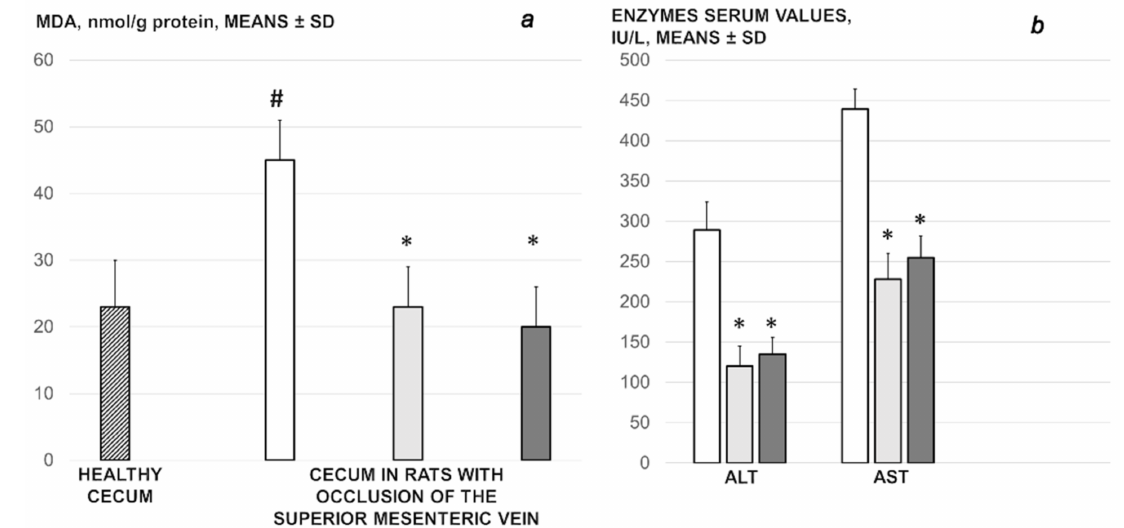
Figure 11. Oxidative stress (MDA, nmol/g protein, means ± SD) ( a ), enzyme serum values (IU/L, means ± SD) ( b ) in the rats with ligated superior mesenteric vein at the end of the 30 min period following medication (BPC 157 10 µ g/kg (light gray bars), 10 ng/kg (dark gray bars); saline 5 mL/kg (white bars)) given intraperitoneally. Six rats/group/interval. * p < 0.05, at least vs. control, # p < 0.05, at least vs. healthy (dashed